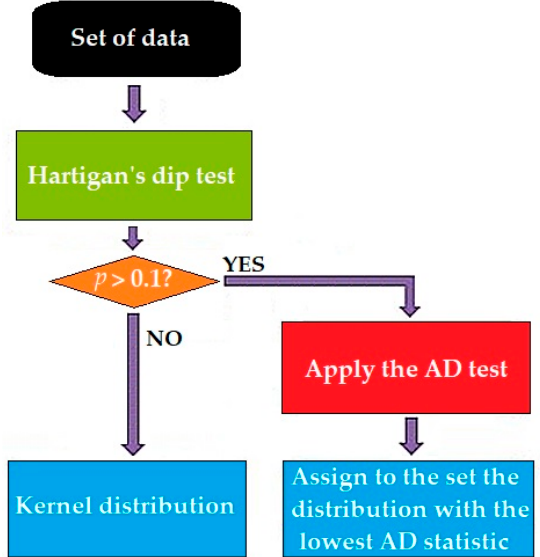
Figure 7. Step-by-step calculation for distribution fitting. Source: own elaboration.